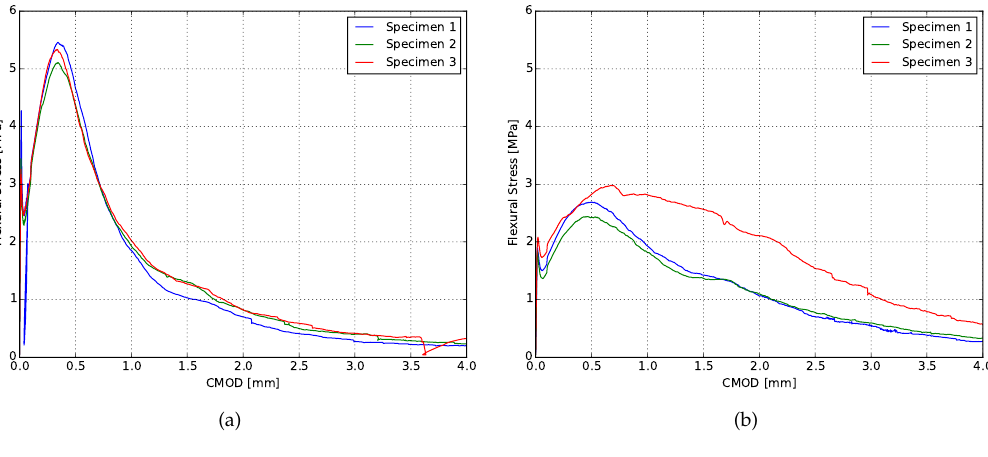
Figure 3. Flexural stress × CMOD curves from fracture toughness tests. ( a ) XVA3PVA20; ( b ) YVA4PVA20-S05. Table 3. Summary of results obtained for the fracture toughness